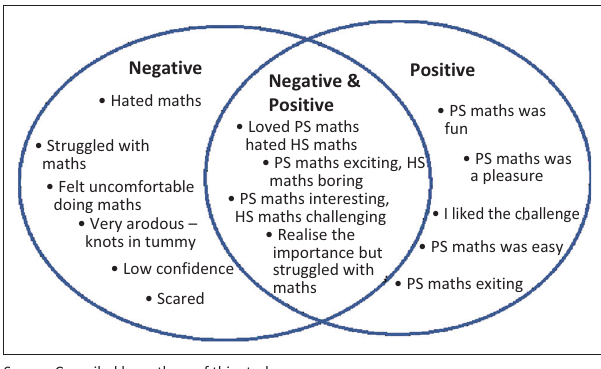
FIGURE 1: Participants’ attitudes towards the learning of